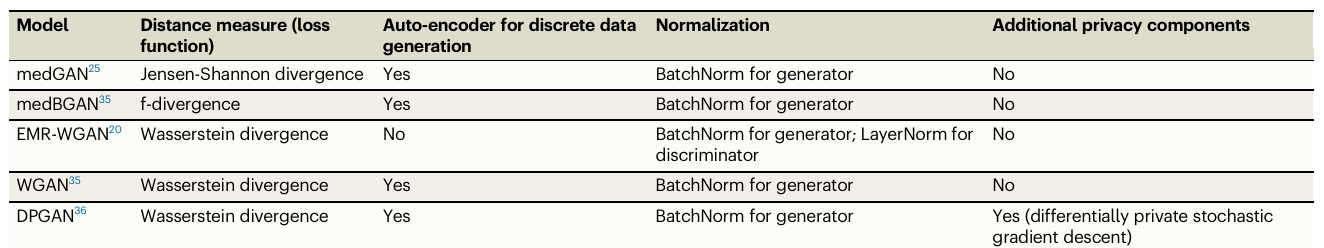
Table 2 | A summary of the GAN models applied for benchmarking